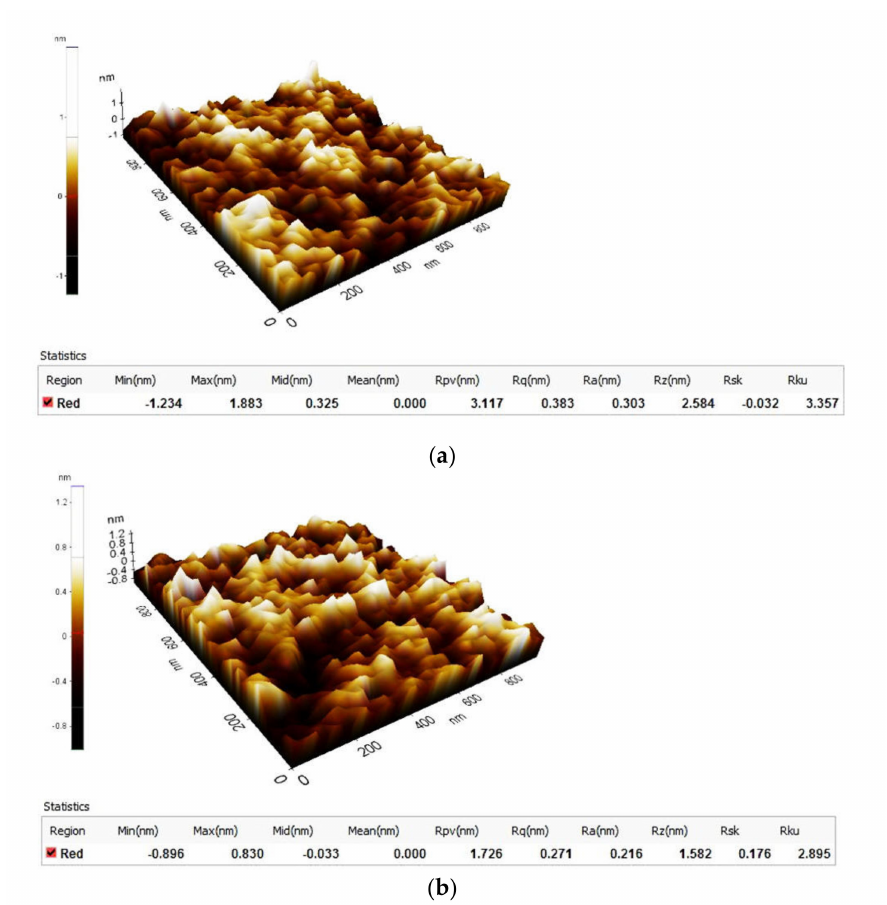
Figure 1. Topography (3D image) and the roughness parameters of: ( a ) SU-8 hard baked at 125 ◦ C; ( b ) SU-8 hard baked at 215 ◦